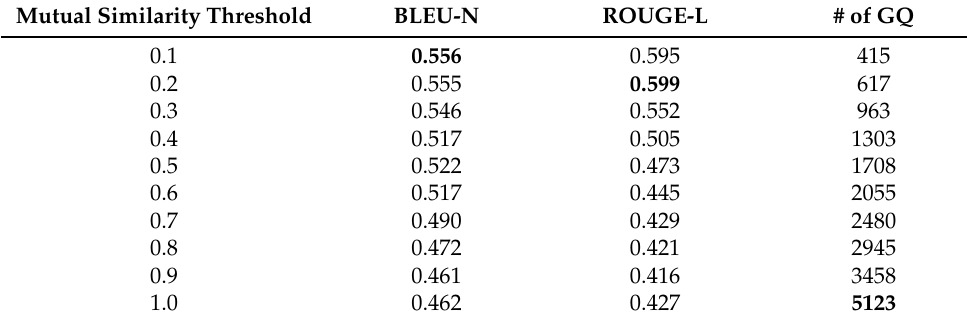
Table 3. Performance Evaluation of Ensemble-NQG-T5 by Mutual Similarity